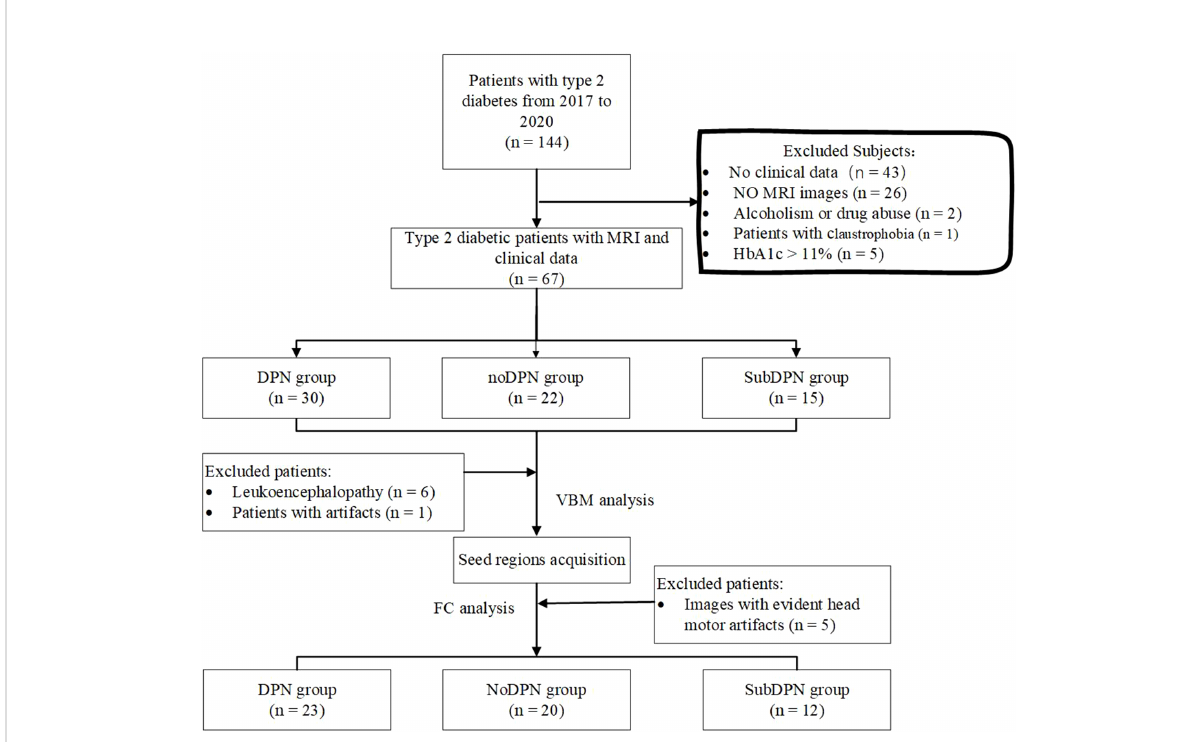
FIGURE 1 Flowchart diagram for subject selection. DPN, type 2 diabetic polyneuropathy; subDPN, subclinical type 2 diabetic polyneuropathy; noDPN,type 2 diabetes without polyneuropathy; MRI, magnetic resonance imaging; VBM, voxel-based morphometry; FC, functional